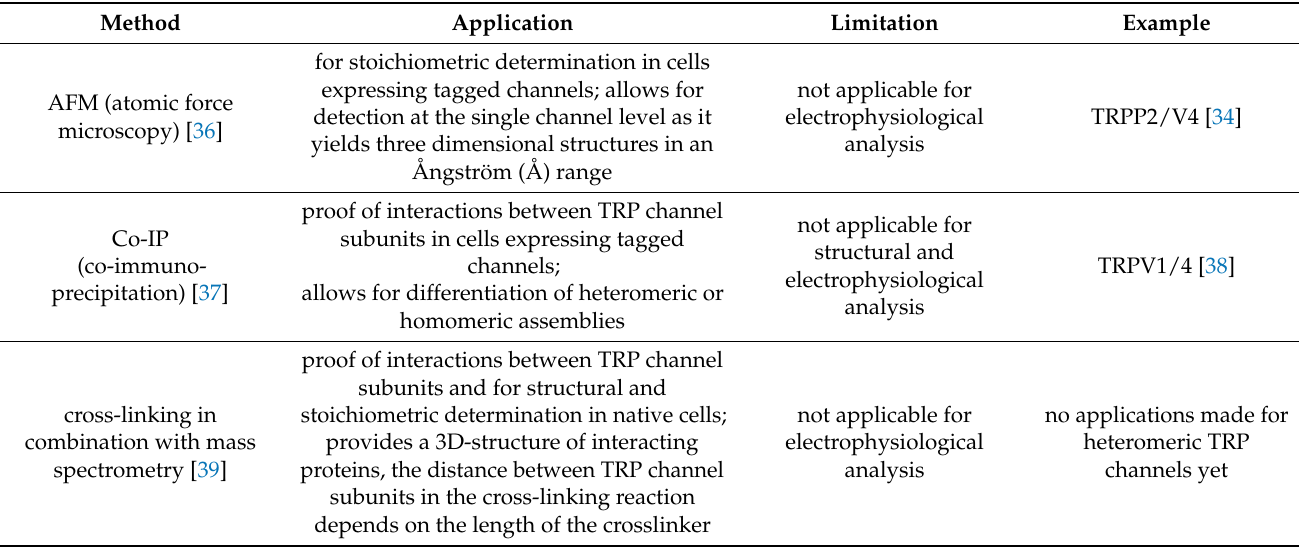
Table 1. Overview of methods for heteromeric TRP channels